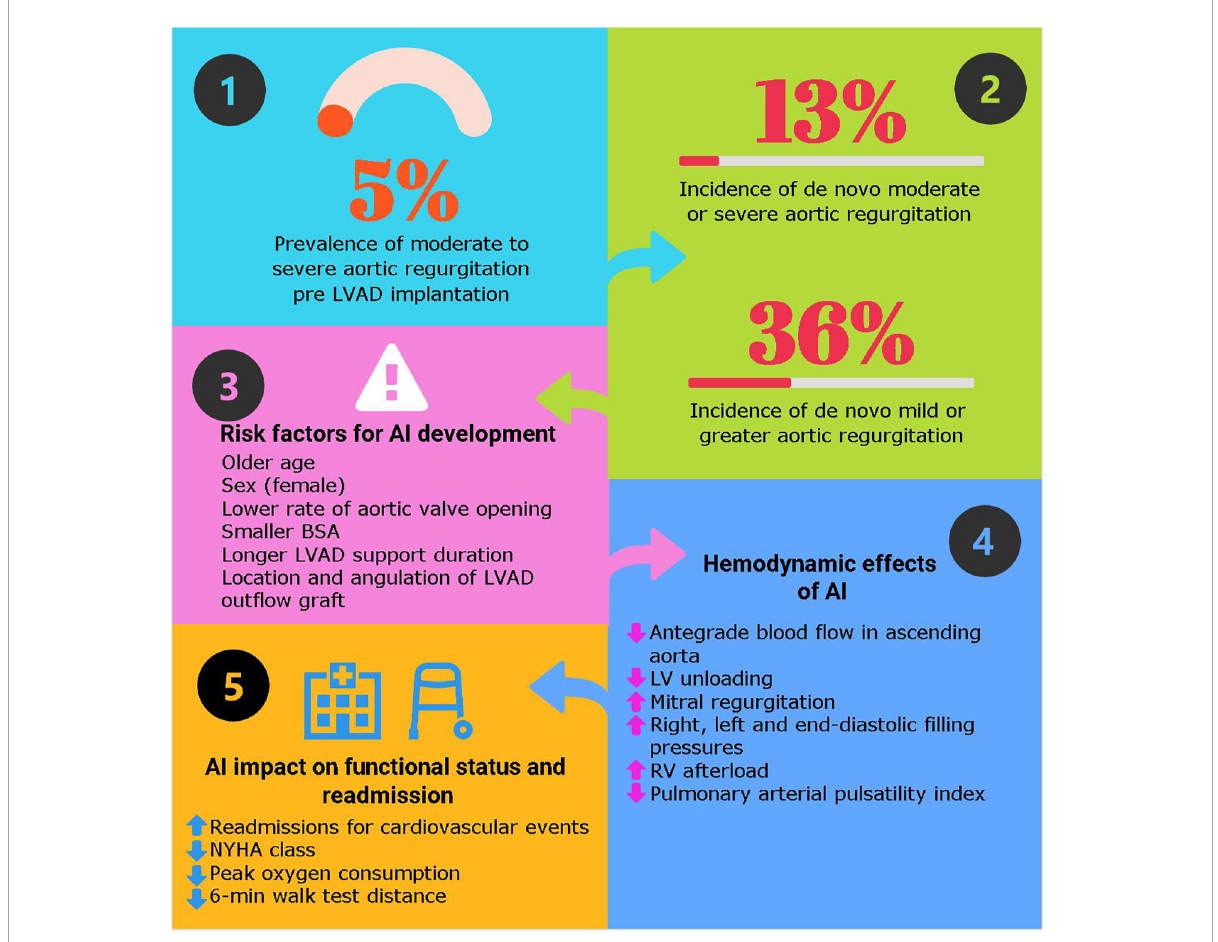
FIGURE1 Key answers about aortic insufficiency in patients with durable left ventricular assist device. Hemodynamic effects of left ventricular assist devices (LVAD) with aortic insufficiency. Adapted with permission from Noly et al.